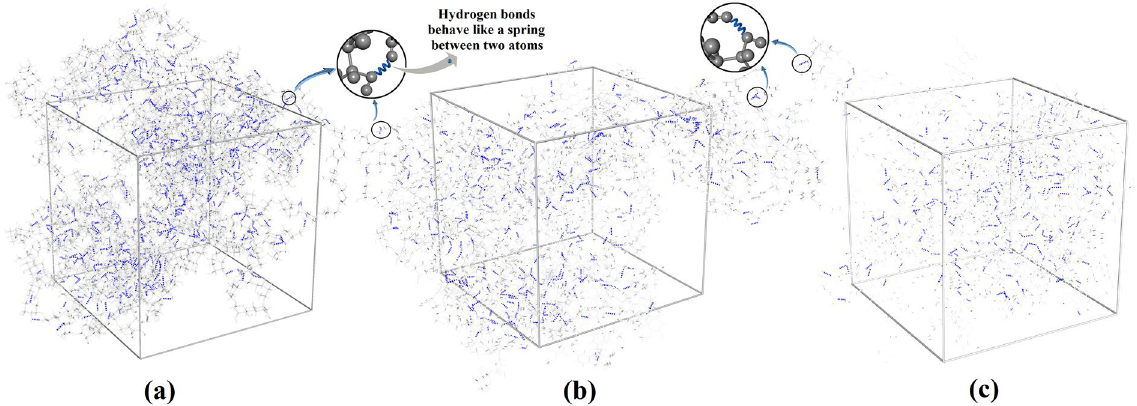
Figure 2. Hydrogen bond distributions of ( a ) Hemicellulose ( b ) LCC ( c ) Lignin. Hemicellulose with larger number of hydroxyl groups forms denser hydrogen bond network than lignin. LCC consists of hemicellulose and lignin molecular structure and has an intermediate hydrogen bond network between hemicellulos and lignin. These hydrogen bonds, which act like a spring between atoms, constrain their movement and dictate the elastic behavior of these materials.